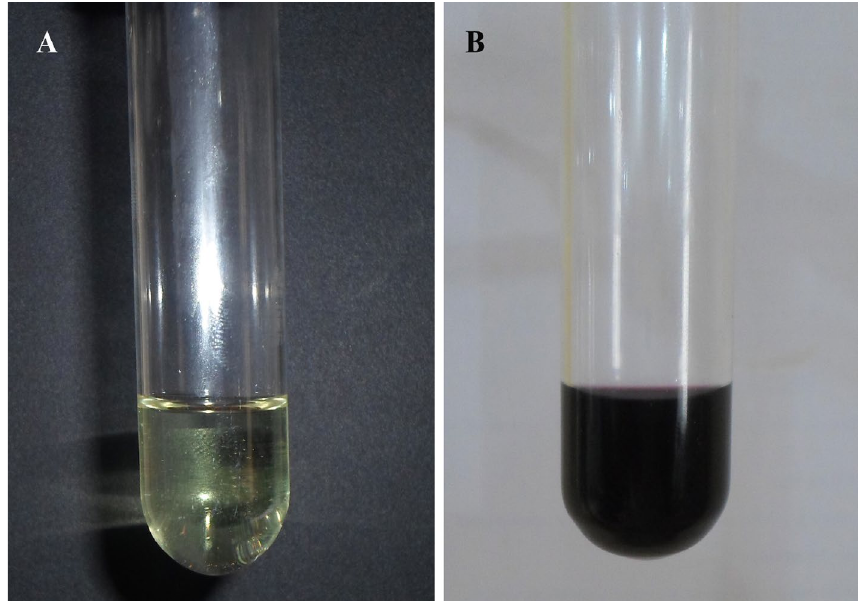
Figure 1. Gold solution ( A ) and gold nanoparticle ( B ) colloidal solution.